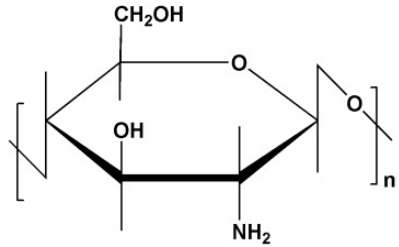
Figure 1. Molecular structure of chitosan.